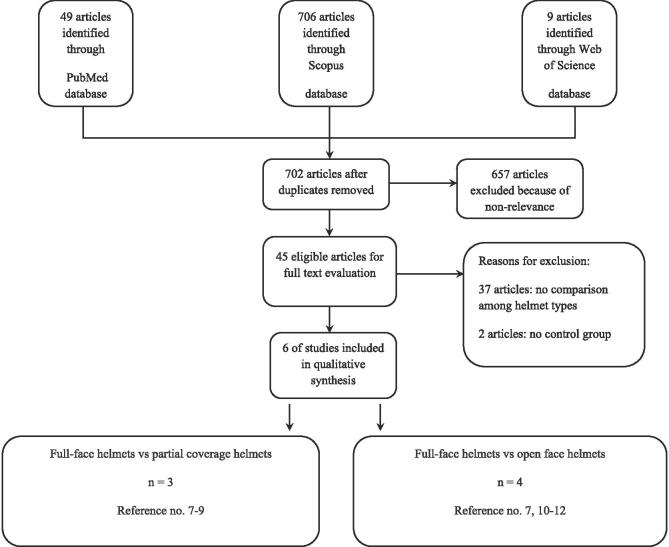
Flow chart of article search using keywords to evaluate helmet types on the prevention of head and neck injuries in motorcycle riders.